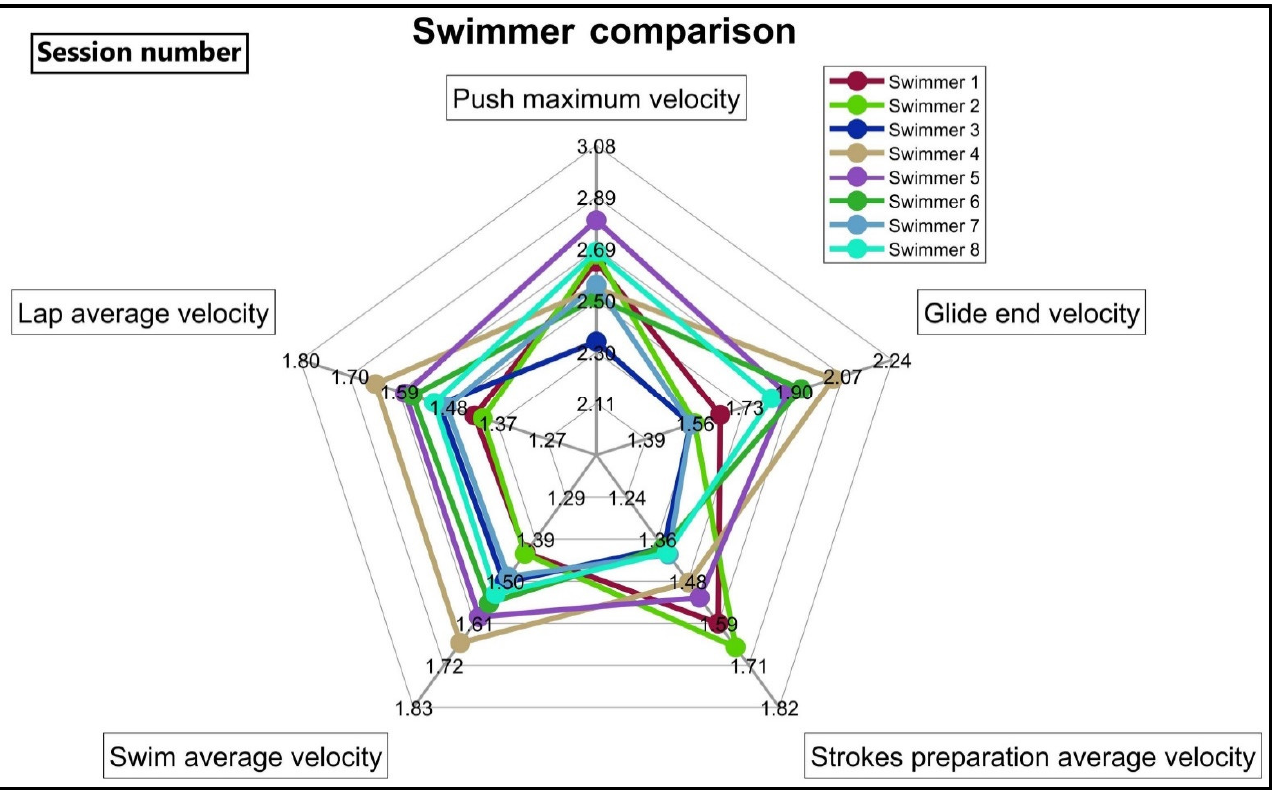
Figure 4. Feedback to compare the swimmer’s average performance in different swimming phases. The coach can see the strengths and weaknesses of each swimmer through this comparison.